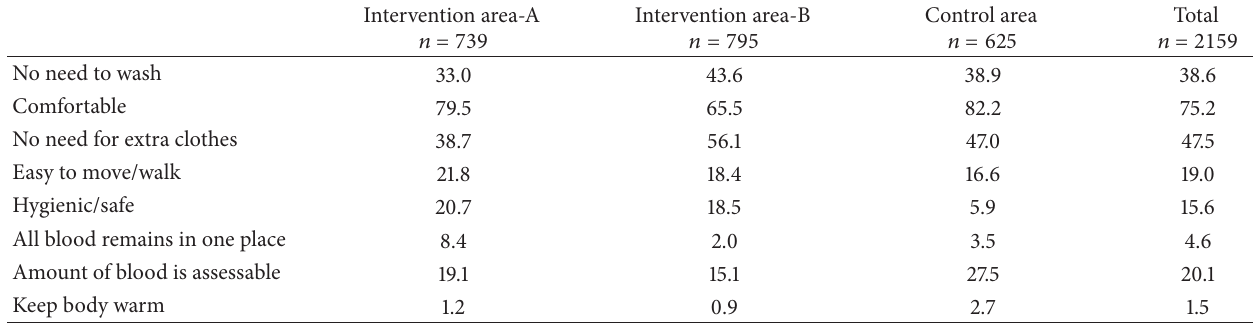
Table 6: Perceived benefits of delivery mat and pads supplied among